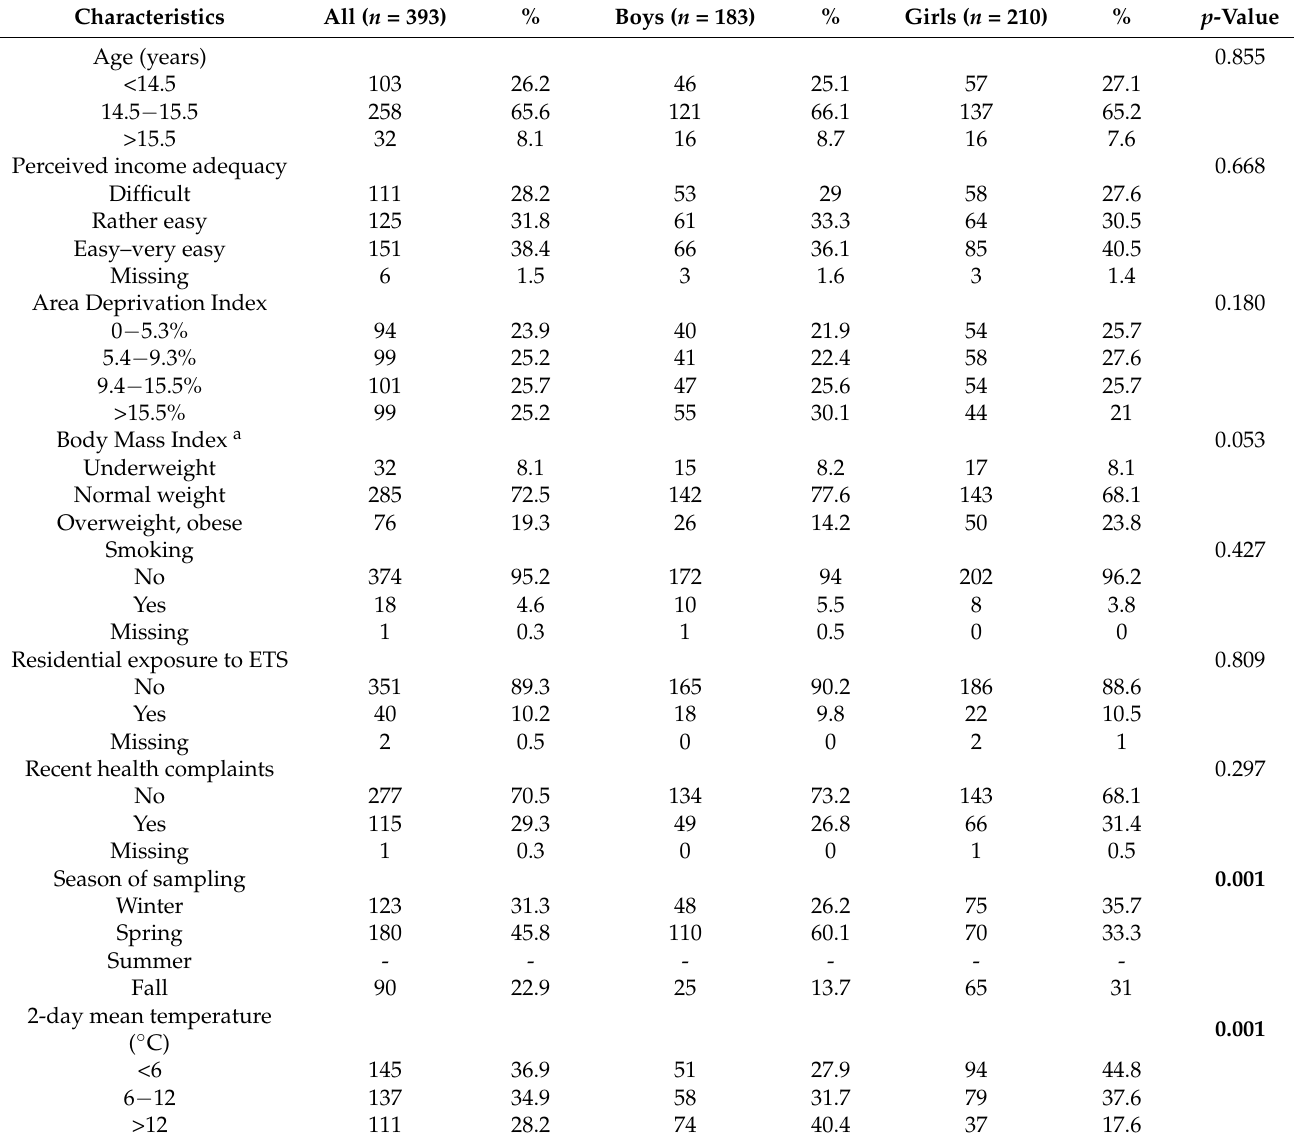
Table 1. Demographic study population